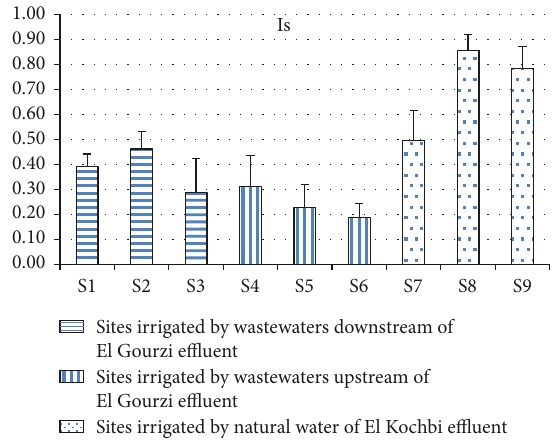
Figure 3: Average of H´enin’s structural stability index in study sites.